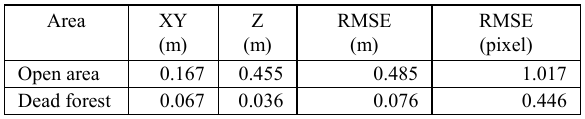
Table 1. Summary of accuracy of bare soil generated UAV DEMs.